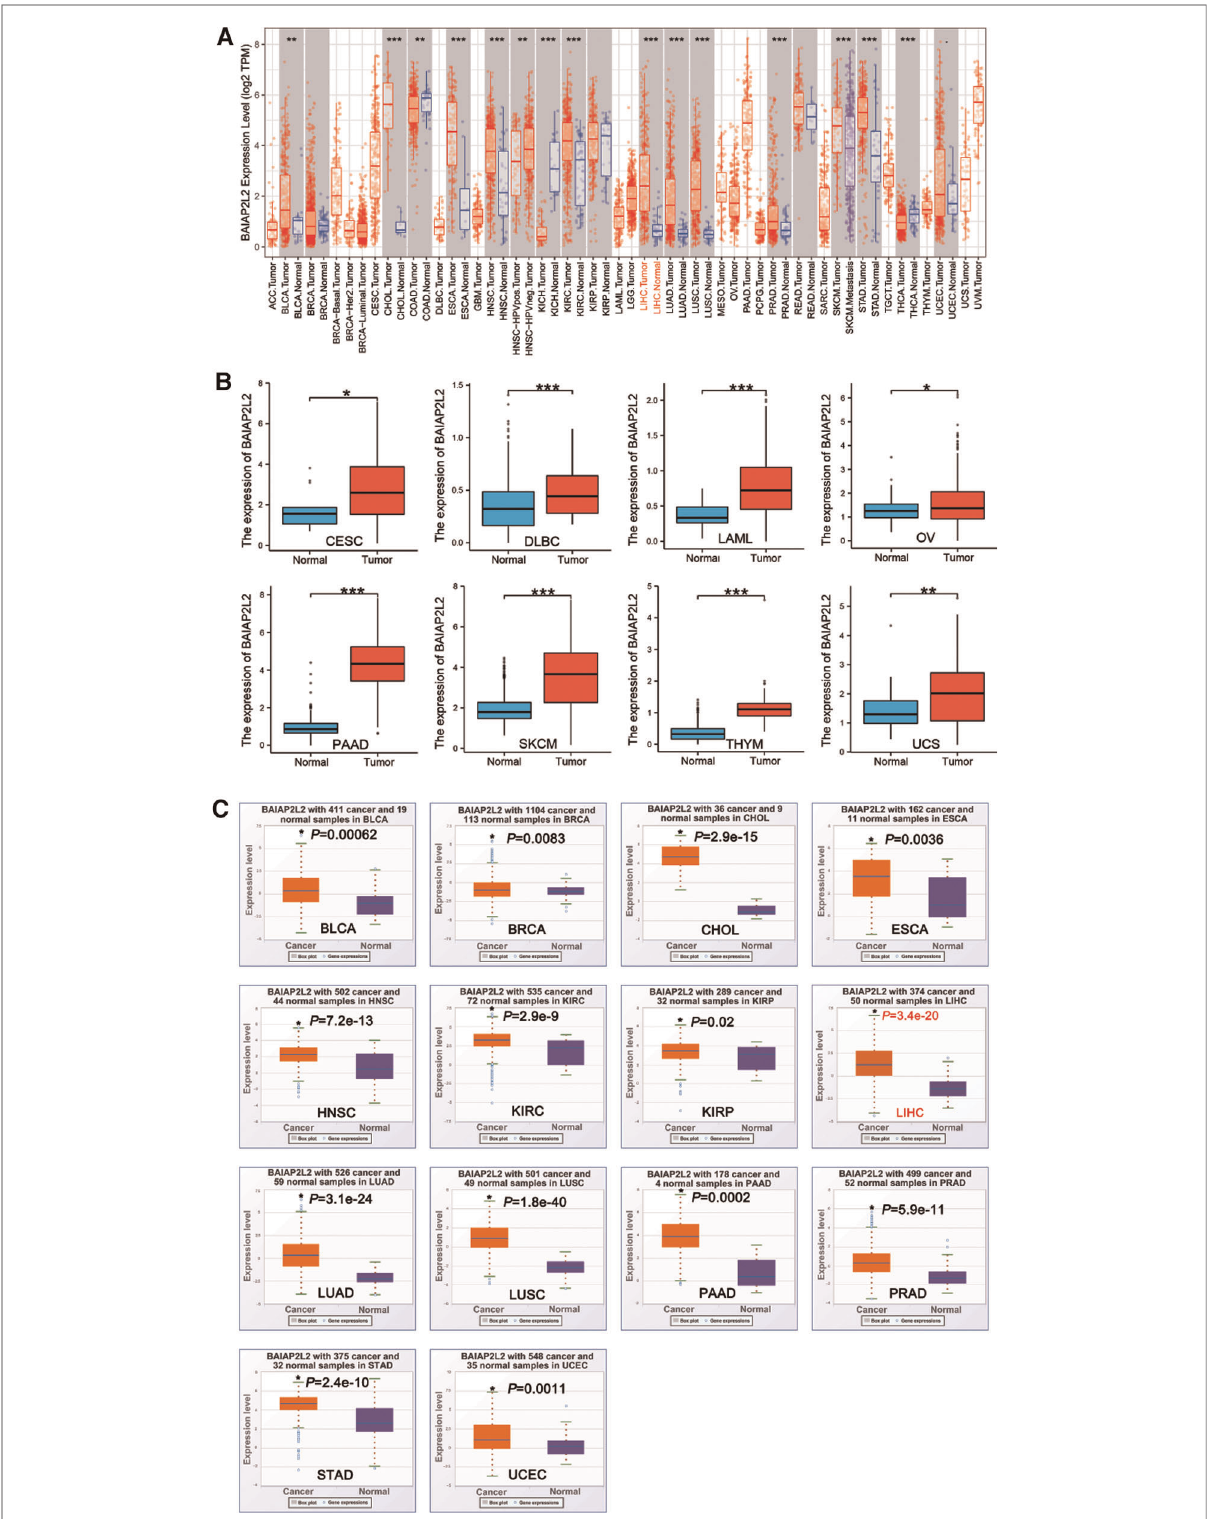
FIGURE 1 BAIAP2L2 expression levels in different types of cancer. ( A ) BAIAP2L2 expression levels in different types of cancer from TCGA datasets in TIMER. ( B ) BAIAP2L2 expression levels in different types of cancer from GTEX database combined with the TCGA database. * p <0.05, ** p <0.01, *** p <0.001. (C ) Upregulated transcriptional level of BAIAP2L2 in pan-cancer samples from the StarBase database. The orange and purple boxes represent cancer and Normal samples, respectively, * p <0.05 compared to the Normal